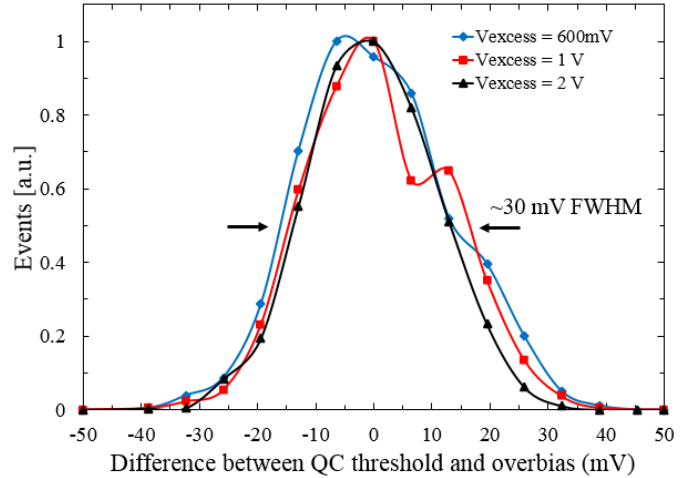
Figure 16. Derivative of the S-curve of the discrimination of the SPAD signal showing a SPAD excess voltage variation of about 30 mV FWHM. The lines are not a fit, they are drawn to guide the